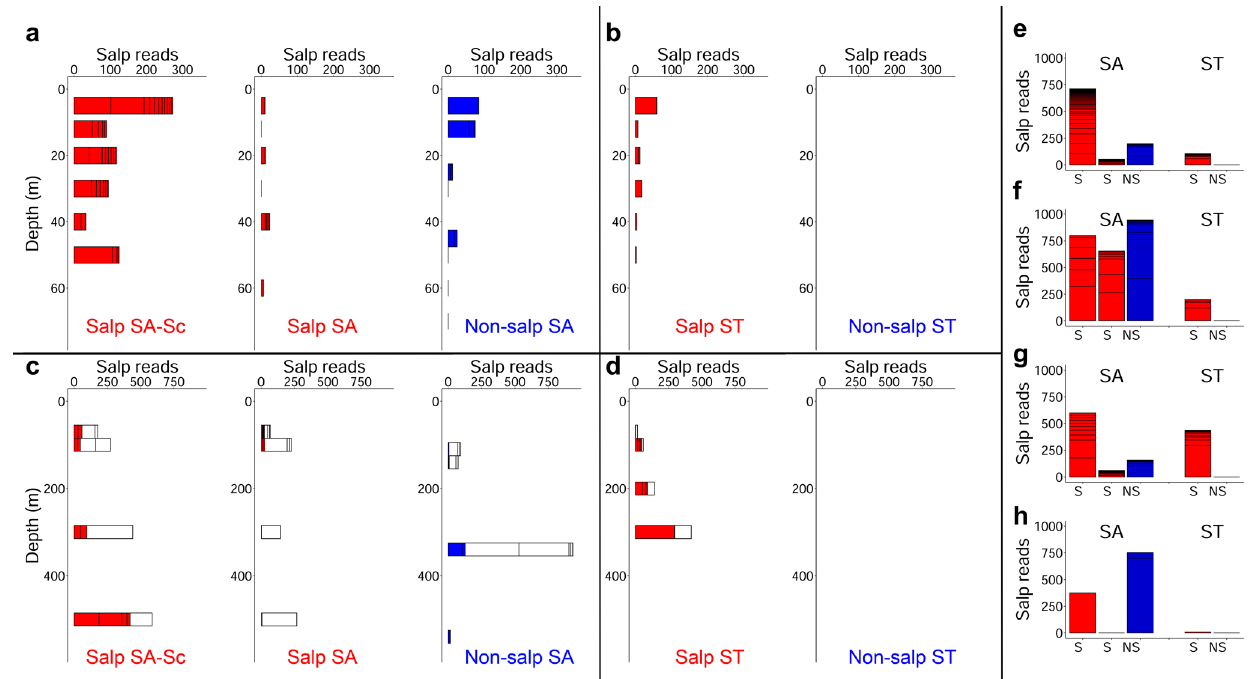
Fig.8 |Salpreadsinthewatercolumn,sinking particles,andsedimentsonthe sea fl oor. Salp reads in the euphotic zone for a Subantarctic (SA) waters, and b Subtropical(ST)waters.NumberofreadsinParticleInterceptortraps( fi lled)and in situ pump (white) bars in c SA waters and d ST waters. Integrated amplicon